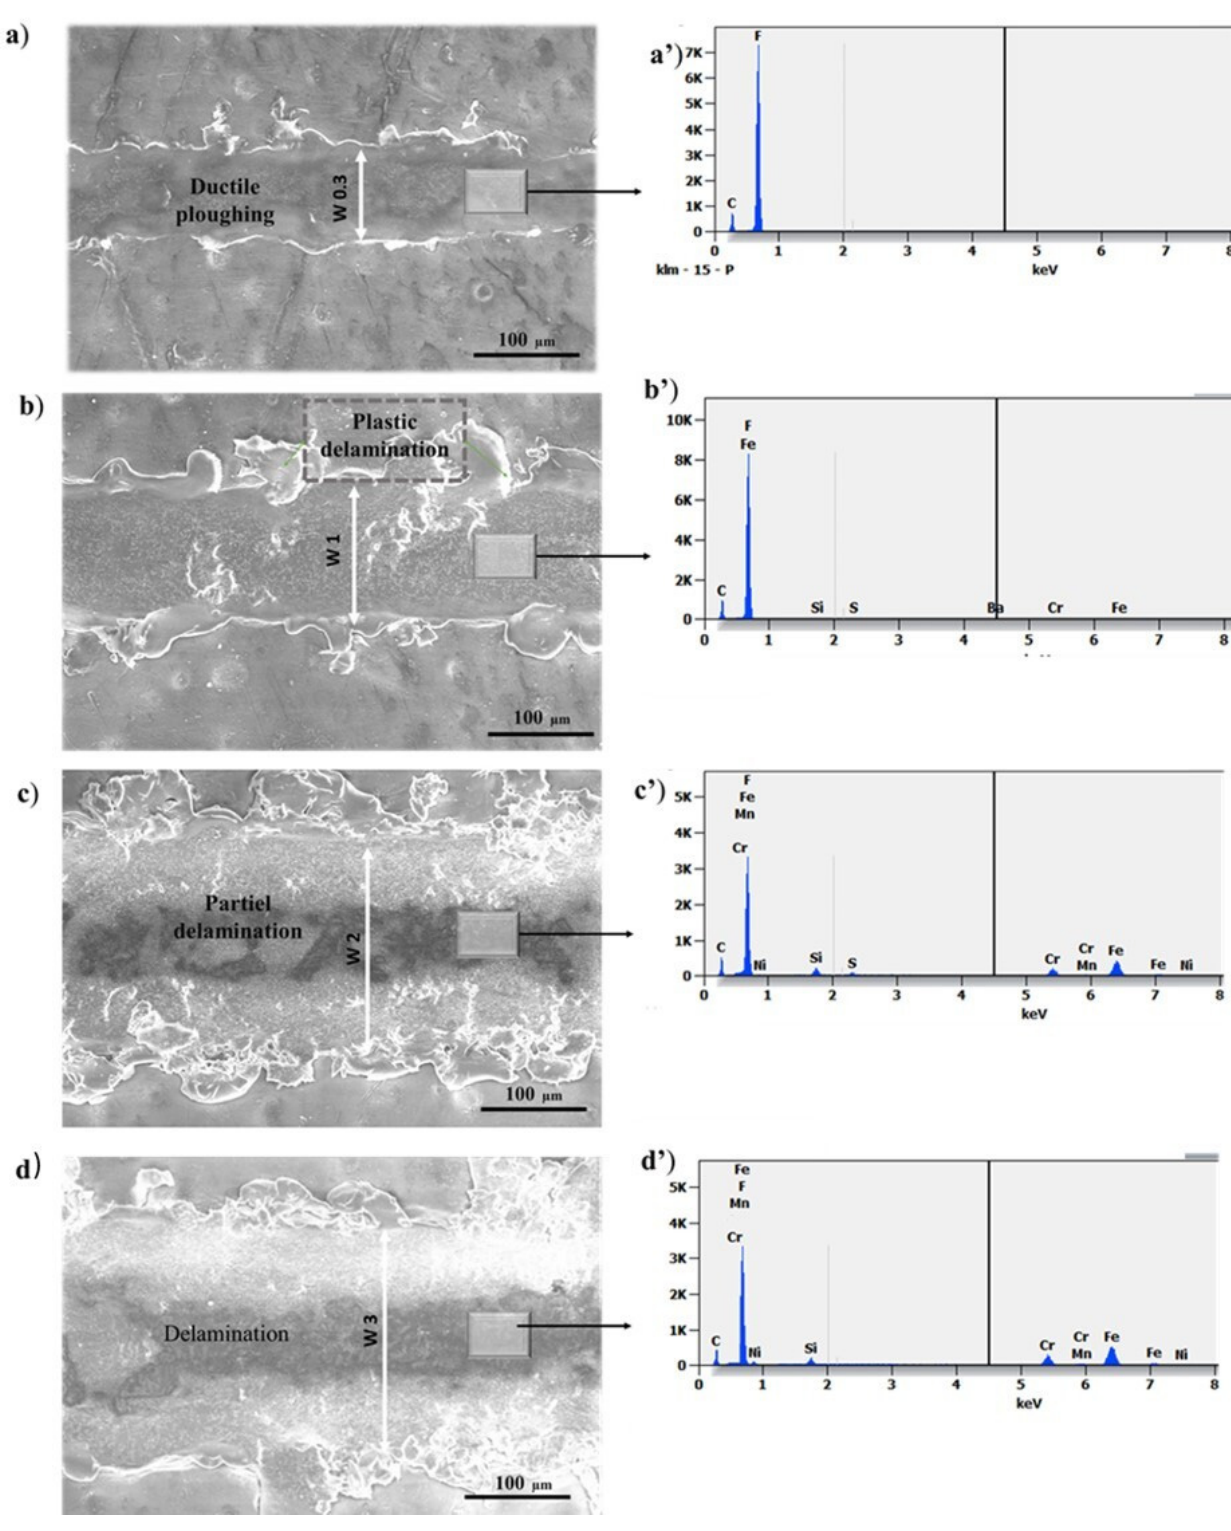
Figure 5. SEM micrographs and corresponding EDS analyses of 100-pass scratch tracks at ( a ) 0.3 N, ( b ) 1 N, ( c ) 2 N, and ( d ) 3 N.